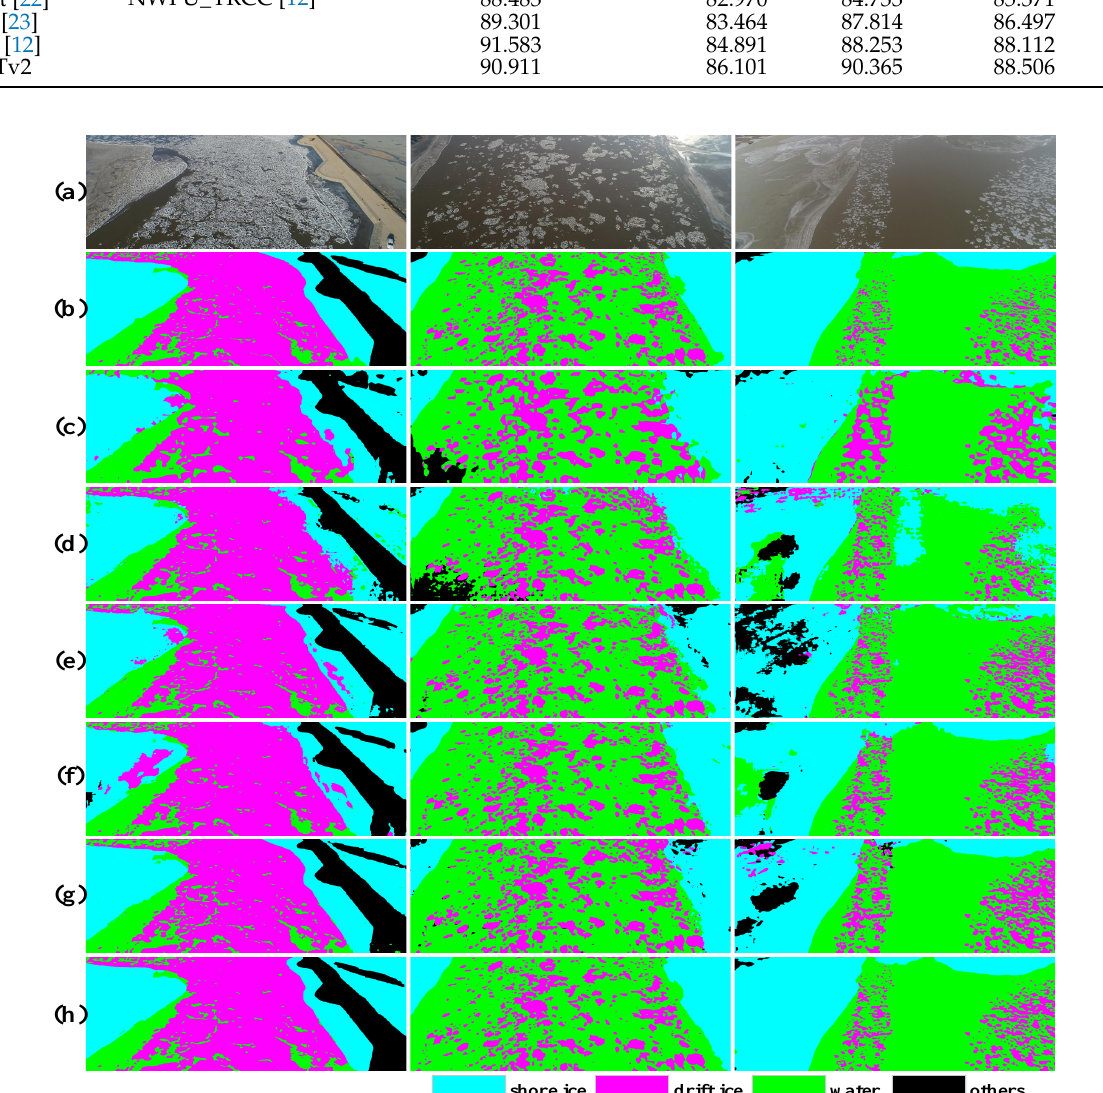
Figure 10. Comparison of different methods on the NWPU_YRCC2 dataset. ( a , b ) respectively represent the images and the corresponding labels. ( c – h ) respectively represent the results of algorithm DeepLabV3, DenseASPP, PSPNet, RefineNet, BiseNet, and ICENETv2 on the NWPU_YRCC2 dataset, arranged in ascending order by MIoU in Table